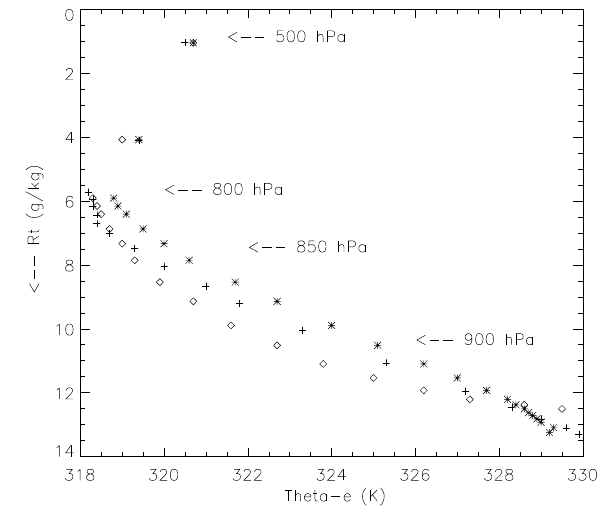
Fig. 12. Conserved variable diagram of the total water content (Rt) and the θ e for a 24-h average vertical profile of 192 profiles over the sea for 14 September 1999, as predicted by the MRF (*), the ETA (+), and the BLA ( ♦ )